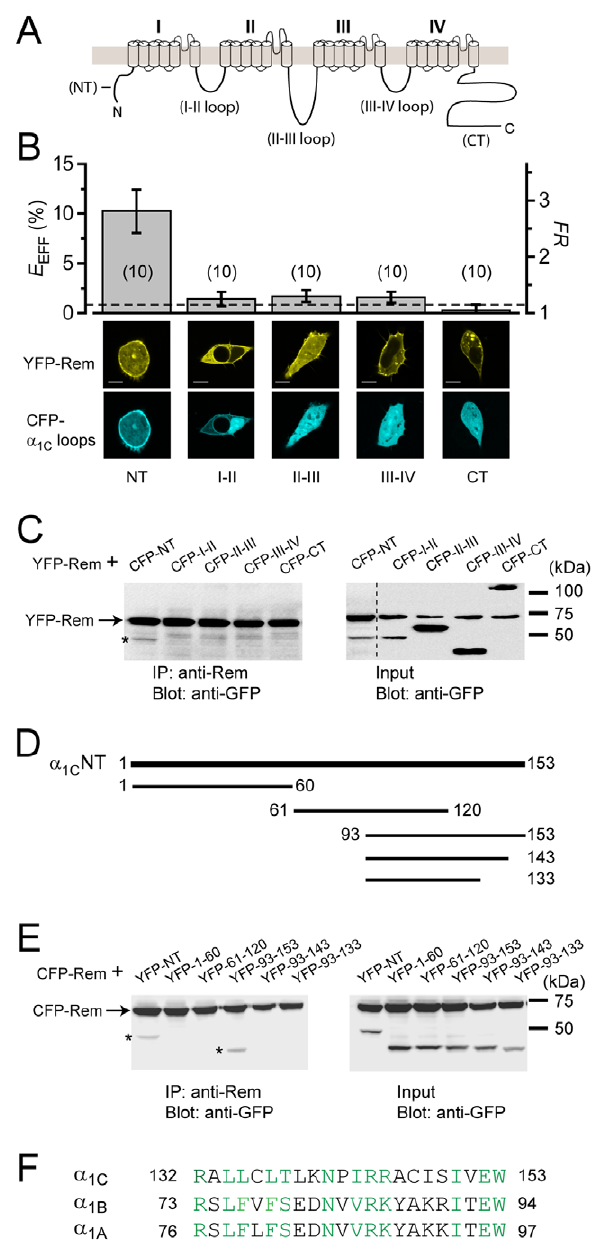
Figure 3. Rem binds a 1C N-terminus. (A) Schematic of a 1C showing four homologous transmembrane domains (I–IV), intracellular N/C termini and domain-connecting loops. (B) Top , interaction of individual CFP-tagged a 1C intracellular loops and termini with YFP-Rem probed using FRET. Dotted line represents YFP-Rem + CFP ( n =10). Bottom , confocal images. Scale bar, 8 m m. (C) CFP-tagged a 1C NT co-immuno- precipitates with YFP-Rem. All the co-ip lanes and the first input lane were from the same gel. The rest of the input lanes were from a second gel run simultaneously because there were insufficient lanes available in the first gel to accommodate all samples, including marker lanes. Hence, in the input gel image ( right ) the first lane (CFP-NT) was spliced onto the rest of the lanes (dotted line). The co-ip gels have been cropped to remove light chain IgG bands from the precipitating antibody. (D) Schematic of a 1C NT peptide fragments. (E) Co-immuno- precipitation of YFP-tagged a 1C NT peptide fragments with CFP-Rem. (F) Sequence comparison of last 22 N-terminus residues among distinct Ca V 1/Ca V 2 channel a 1 subunits.